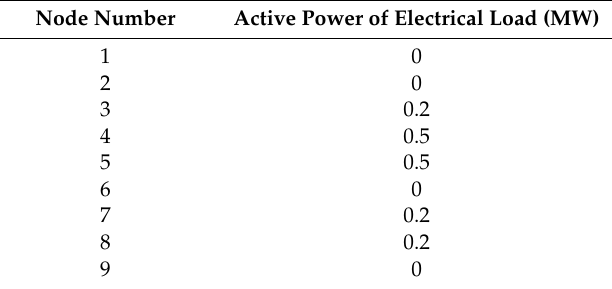
Table A2. Active power of electrical load at each node.